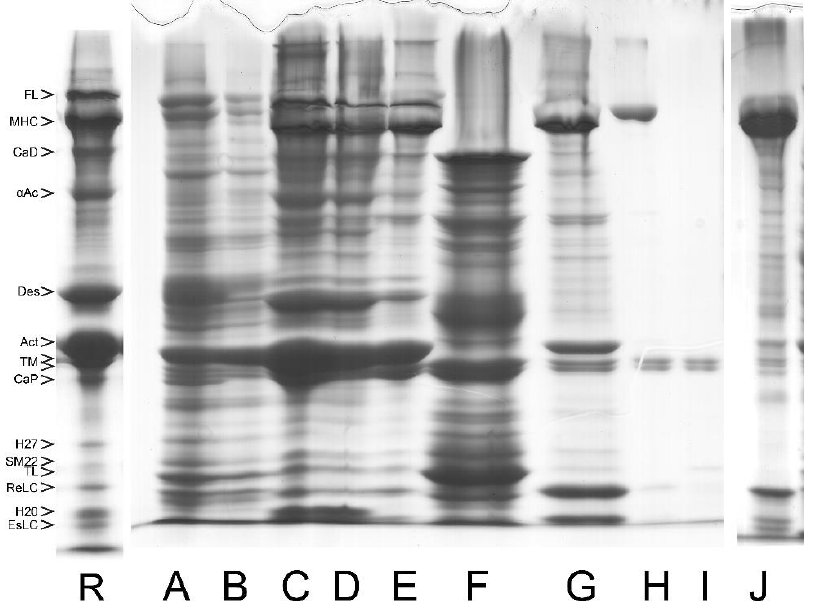
Figure 8. Purification of myosin from bovine tracheal smooth muscle with intermediate extraction of MLCK regulatory complex with kinase extraction solution (KES). Such extraction procedure has been routinely used for purification of the regulatory complex and TL [24,25]. (R) Reference lane. ( A ) First wash of the whole tissue. ( B ) Second wash. ( C ) MYF after the KES extraction. ( D ) Third wash to remove the KES solution. ( E ) LAMES extract or the “alternative crude actomyosin”. ( F ) KES extract as used for MLCK purification. ( G ) CMY (the alternative 40 – 57.5% am. sulf. pellet of crude actomyosin) in AA. TM doublet is clearly visible. ( H ) Myosin loss or the TCA precipitate of the 57.5% am.sulf. supernatant of G. ( I ) TM as the only content (TCA precipitate) of the 57% am.sulf. supernatant of F. ( J ) Purified myosin obtained after the CMY was dialyzed o/n against BW and the filaments pelleted and resuspended in a small volume of AA.